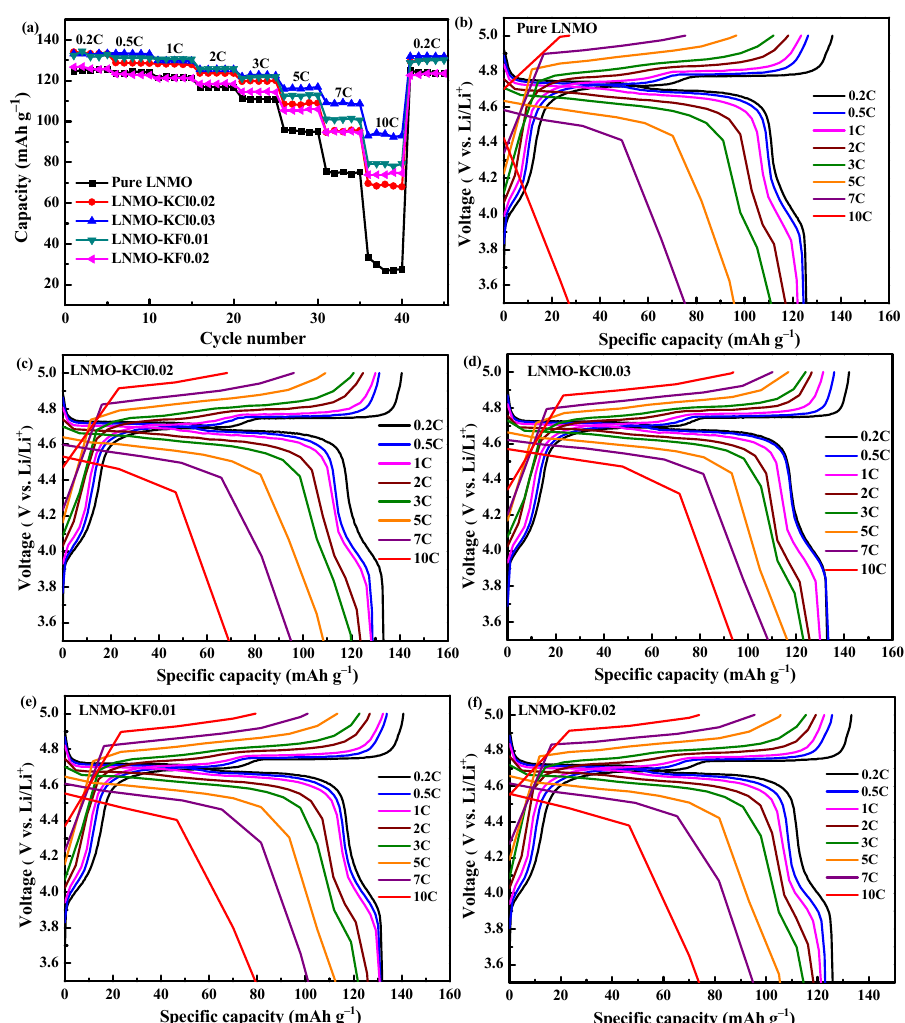
Figure 8. Rate capability of all samples from 0.2C to 10C ( a ); Galvanostatic charge/discharge curves at different C-rates for all samples at 3.5–5.0 V ( b – f ). Table 4. Discharge capacity at different C-rates for all samples between 3.5 and 5 V. Sample